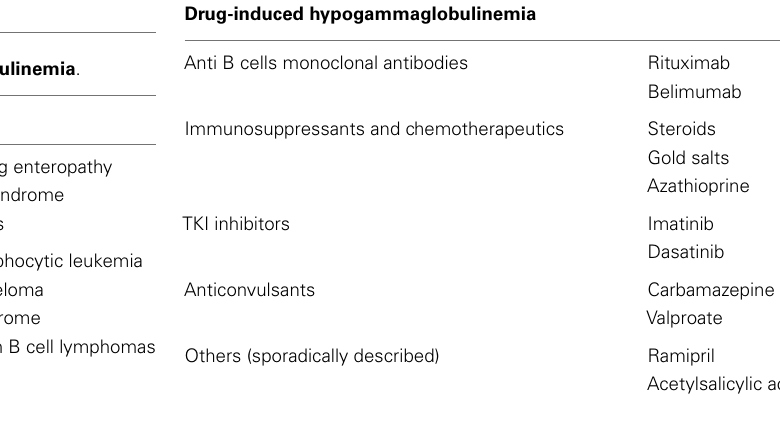
Table 2 | Main causes of drug-induced hypogammaglobulinemia